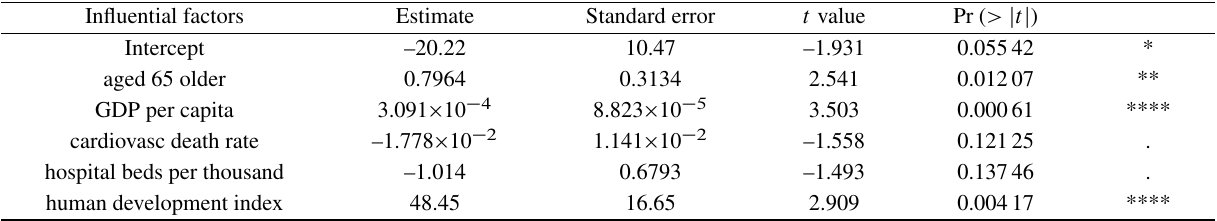
Table 5A Multiple linear regression model with PVPH as the dependent